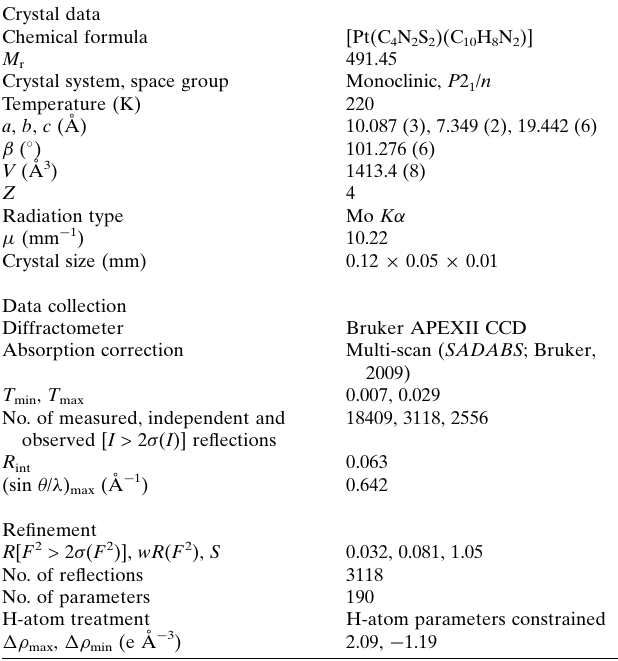
Table 3 Experimental details. Crystal data Chemical